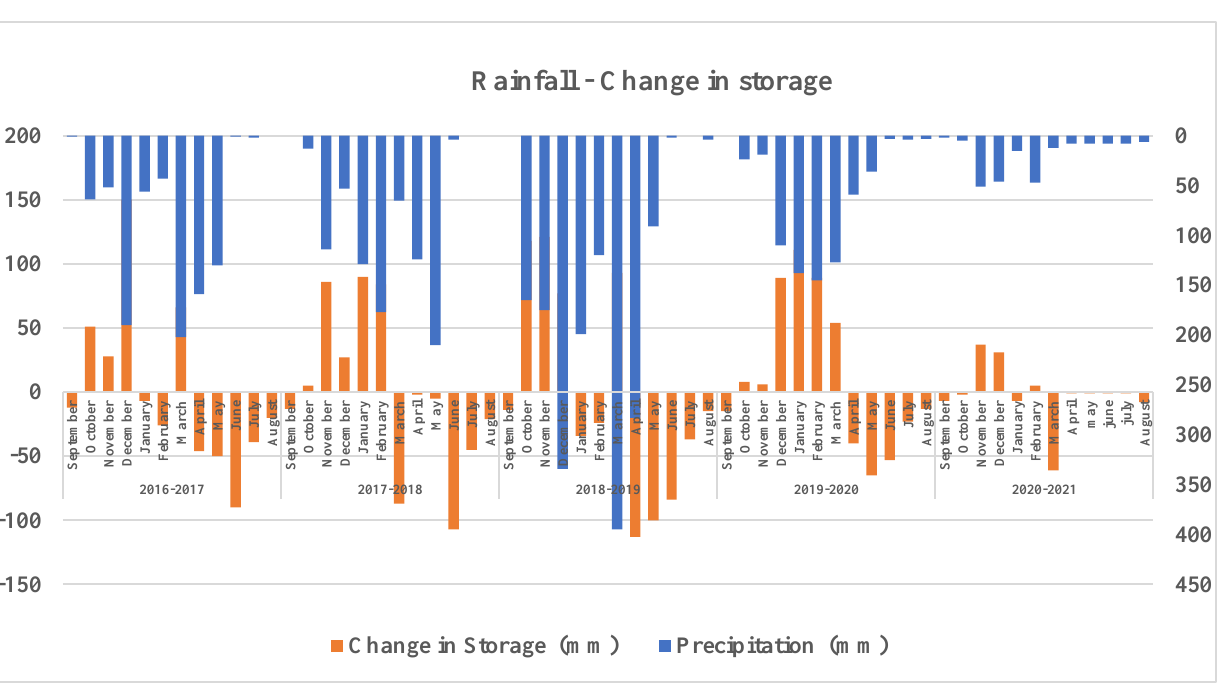
Figure 8. The effect of rainfall amount on the change in storage The annual average of ground water storage in the study area during hydrological years is influenced with changing rainfall amount, so that; the annual average of ground water storage is (31.2 mm, 25.9 mm, 99.9 mm, 18.8 mm and 1.41 mm) for since (2016-2017, 2017-2018, 2018-2019, 2019-2020 and 2020-2021) respectively, these results indicated to water table become very low, shown the bed of the Duhok Dam Lake in figure (9).